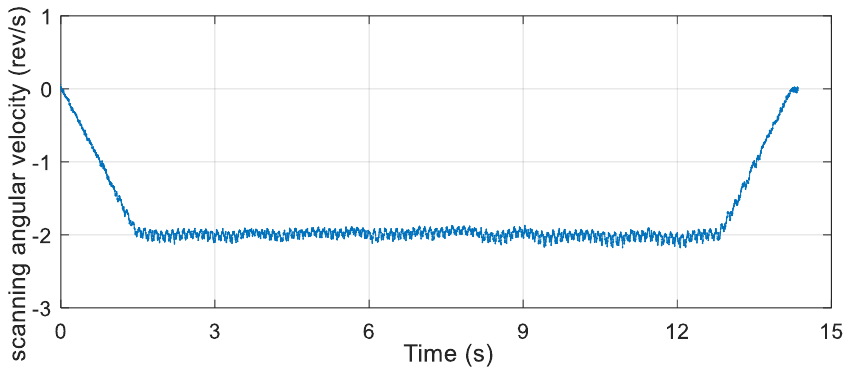
Figure 9. Scanning angle of the semi-physical simulation.